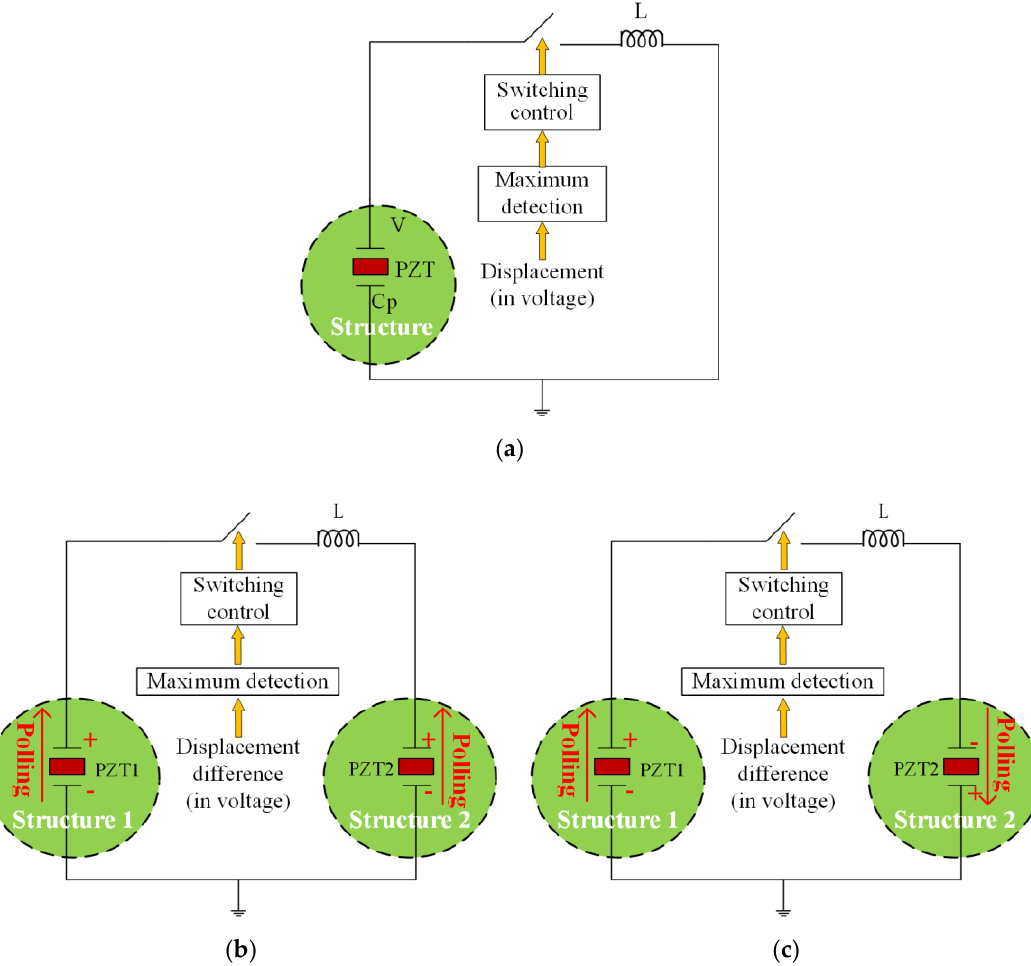
Figure 1. The schematic plots of ( a ) the conventional synchronized switching damping inductance (SSDI), ( b ) the dual-connected SSDI with PP (positive-to-positive) connection and ( c ) the dual-connected SSDI with PN (positive-to-negative) connection.